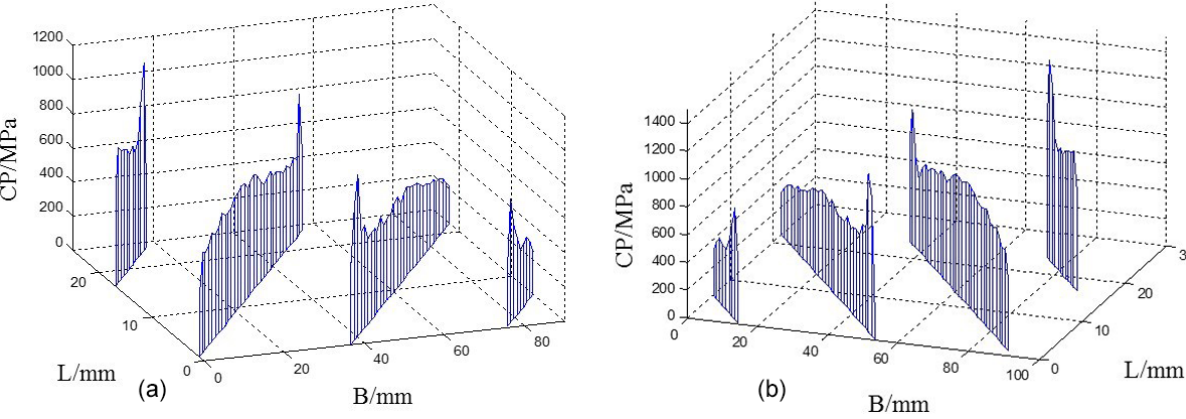
Figure 17. Contact stress distribution of the tooth surface with the stiffness of the no. 2 shaft section. (a) Left tooth surface. (b) Right tooth